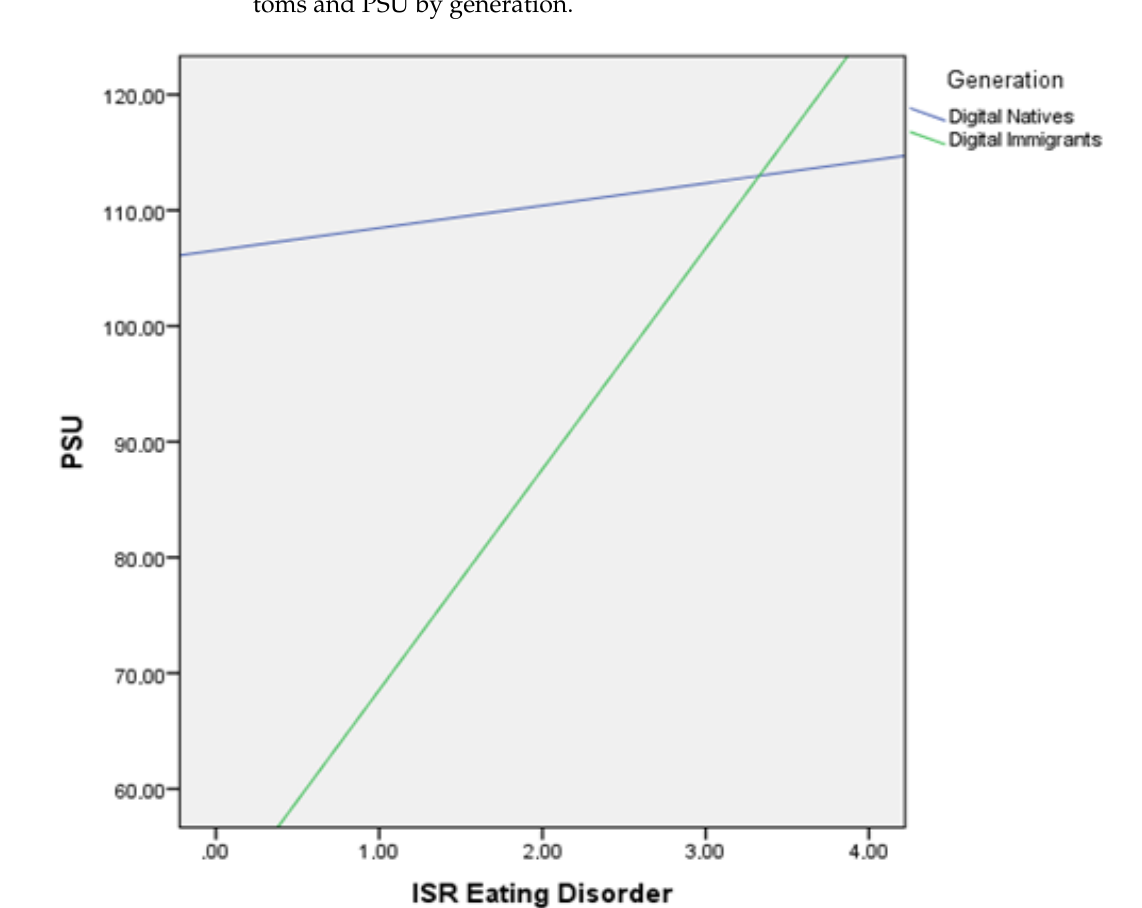
Table 4. Moderation for digital natives and digital immigrants.